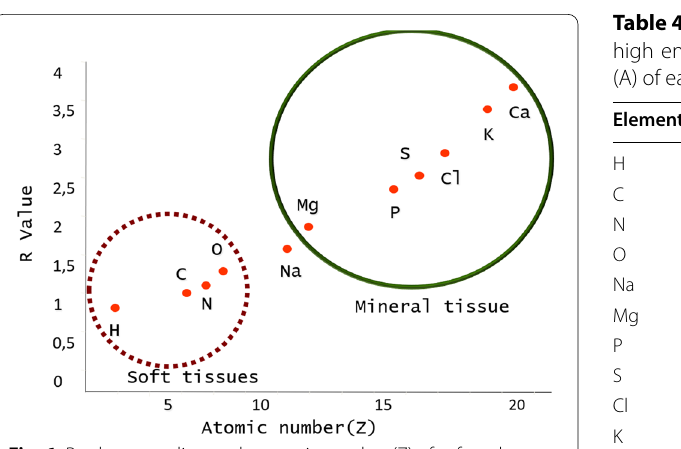
Fig. 6 R value according to the atomic number (Z) of soft and mineralized tissues